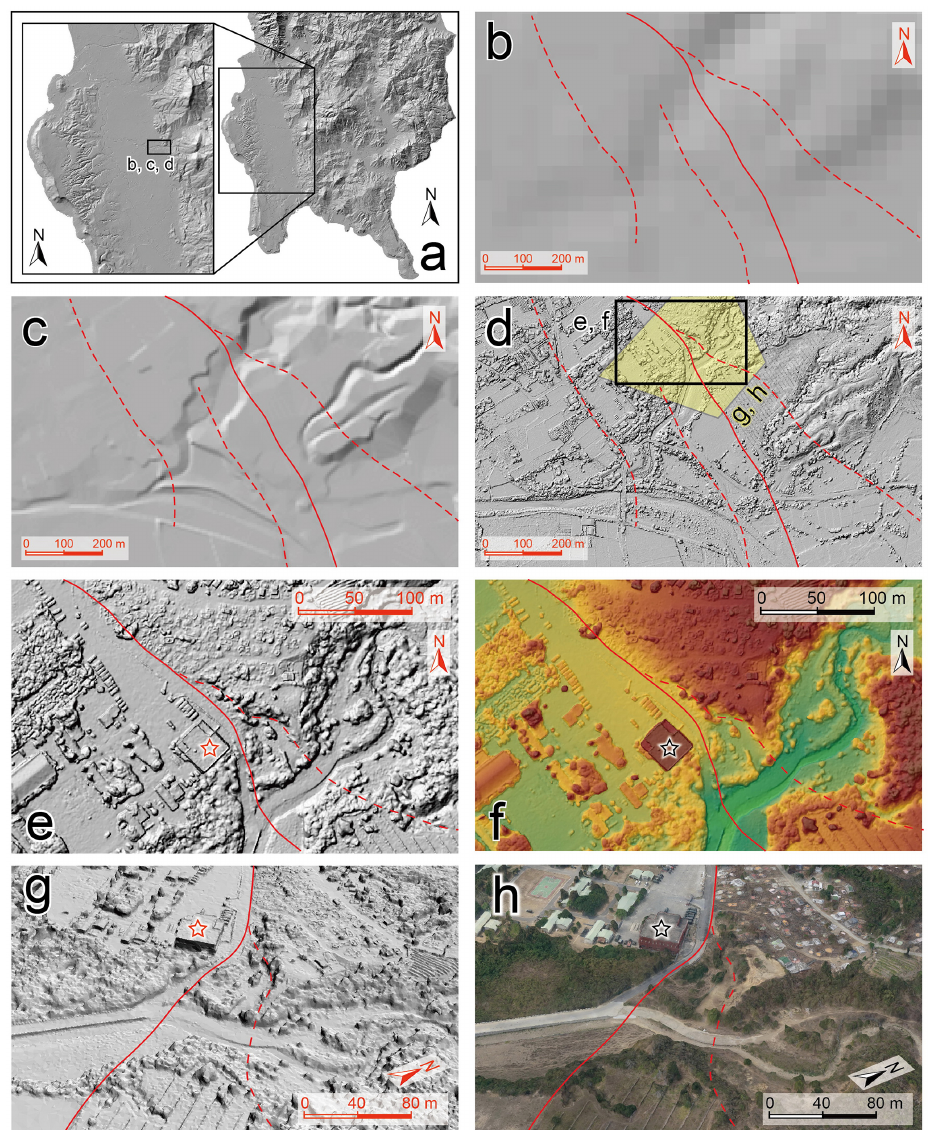
Figure 3. Comparisons of topographic digital data sets for the same area acquired from different sources, including 40m DTM, 5m DEM and 0.13m UAS DSM. Heavy and dashed (inferred) red lines correspond to fault lines. (a) Location of the data set of panels (b, c, d) ; (b) 40m resolution DTM commonly used in Taiwan; (c) 5m resolution DEM generated in 2003; (d) 0.13m resolution UAS-derived DSM generated in this study. There are great differences in the quality of the different digital topography. Panels (e) and (f) highlight different parts of the UAS DSM: (e) enlargement of the hill-shaded UAS DSM, (f) enlargement of color-shaded UAS DSM, (g) side view of the hill-shaded true 3-D model and (h) side view of the image draped onto the true 3-D model (g) . The side views of panels (g) and (h) are captured at the same position and orientation. The star indicates the same building shown in panels (f) , (g) and (h) . The locations of panels (b) , (c) and (d) are indicated in panels (a) , whereas panels (e) and (f) are indicated in panel (d) . One can see the quality of the newly acquired UAS DSM that enable us to photointerpret precisely the location of the geology and the